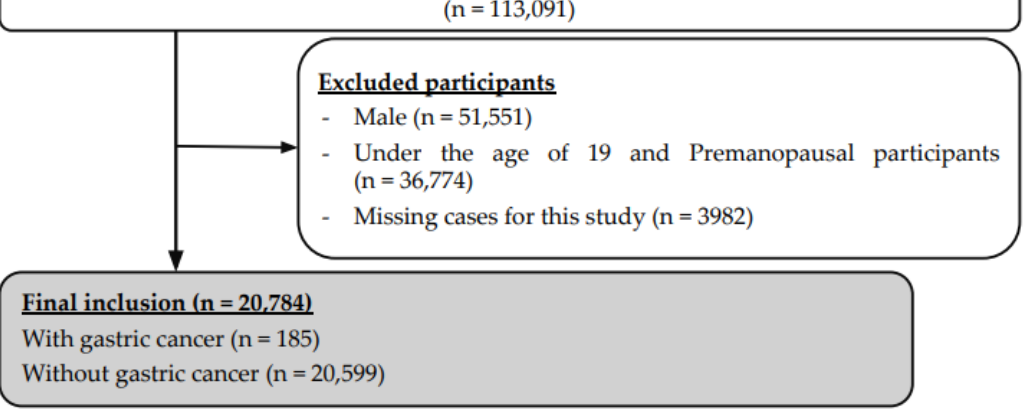
Figure 1. Flow chart for selection of the study population. Abbreviation: KNHANES, Korea National Health and Nutrition Examination Survey. Table 1. Sample distribution by study year.